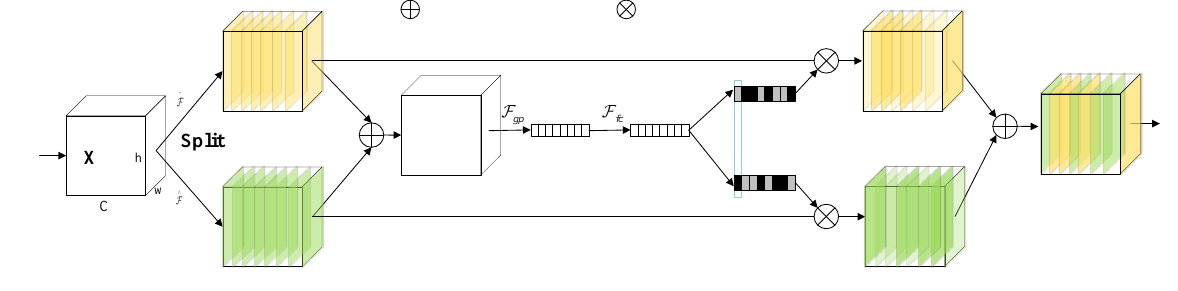
Figure 3. SK module structure.